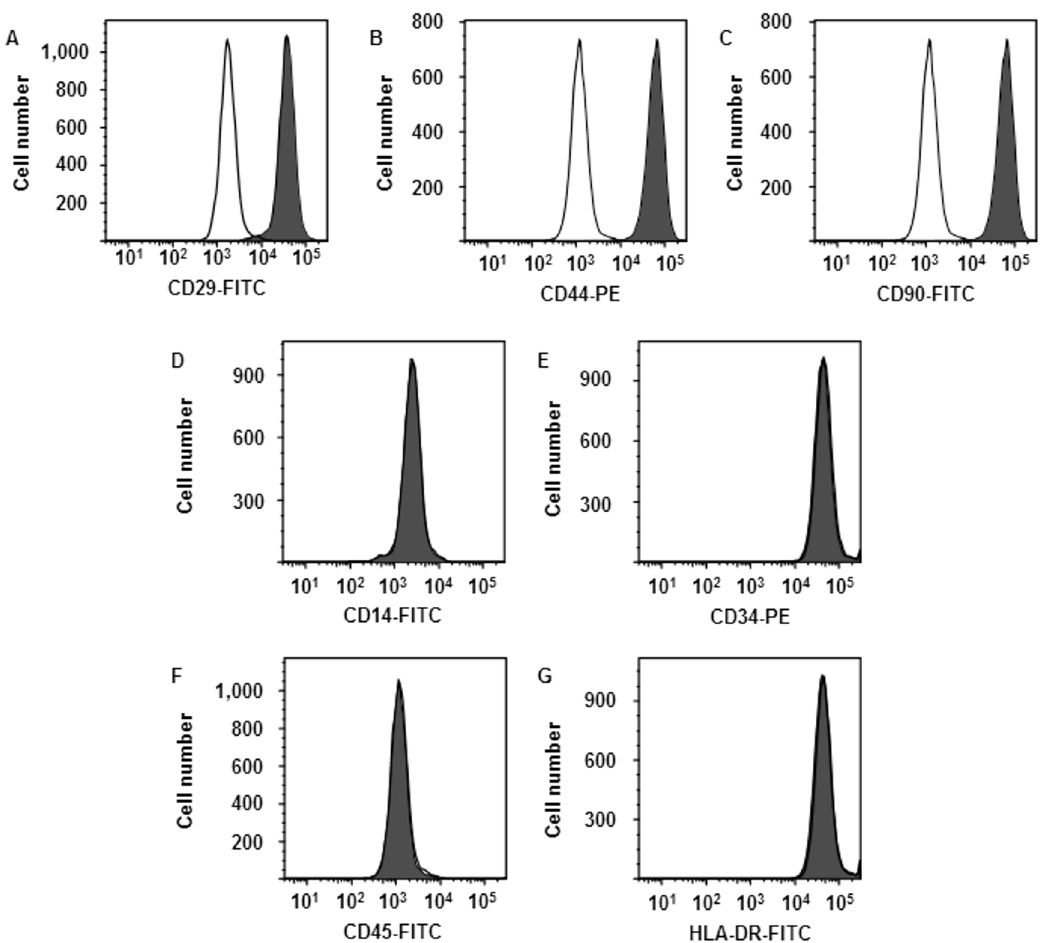
Fig 1. Characterization of synovial fibroblasts by flow cytometry. Synovialfibroblastswere isolatedfrom three male beagledogs. Solid and open histograms show non-specific and specific staining for the indicatedmarker, respectively. Cells were strongly positive for the fibroblast markers CD29, CD44, and CD90. In contrast, most of the cells were negativefor the hematopoietic cell markers CD14, CD34, CD45, and HLA-DR. Results are representative in three independent